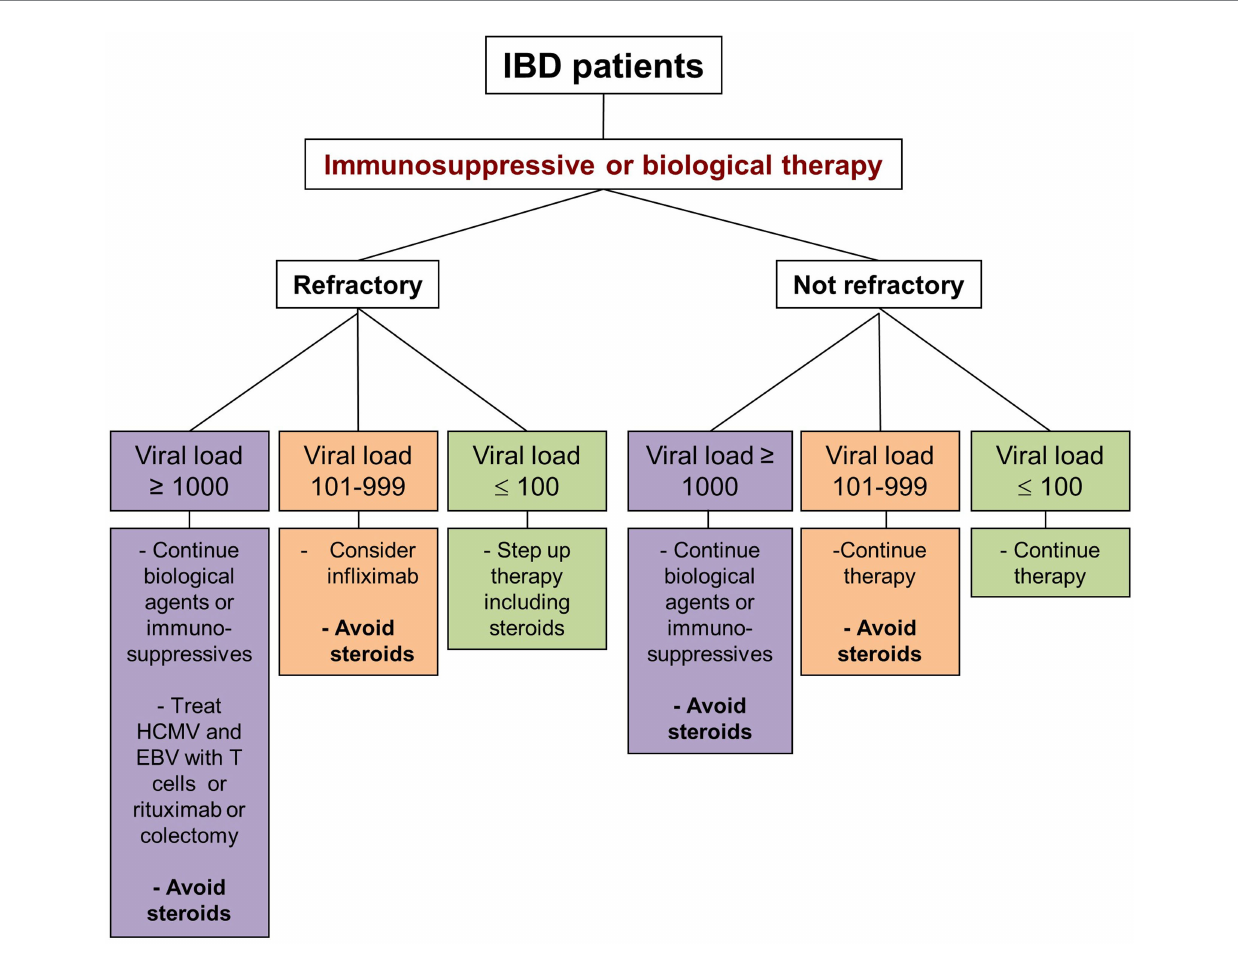
FIGURE 2 Schematic representation of the management of patients with inflammatory bowel disease treated with immunosuppressants or biologics and developing a viral colitis sustained by human cytomegalovirus (HCMV) and/or Epstein–Barr virus (EBV). Depending on colitis refractoriness and the viral load, different scenarios are depicted. The assessment of the viral load is crucial, as HCMV and EBV may be normally found in very low concentrations in the gut mucosa and are considered innocent bystanders in this